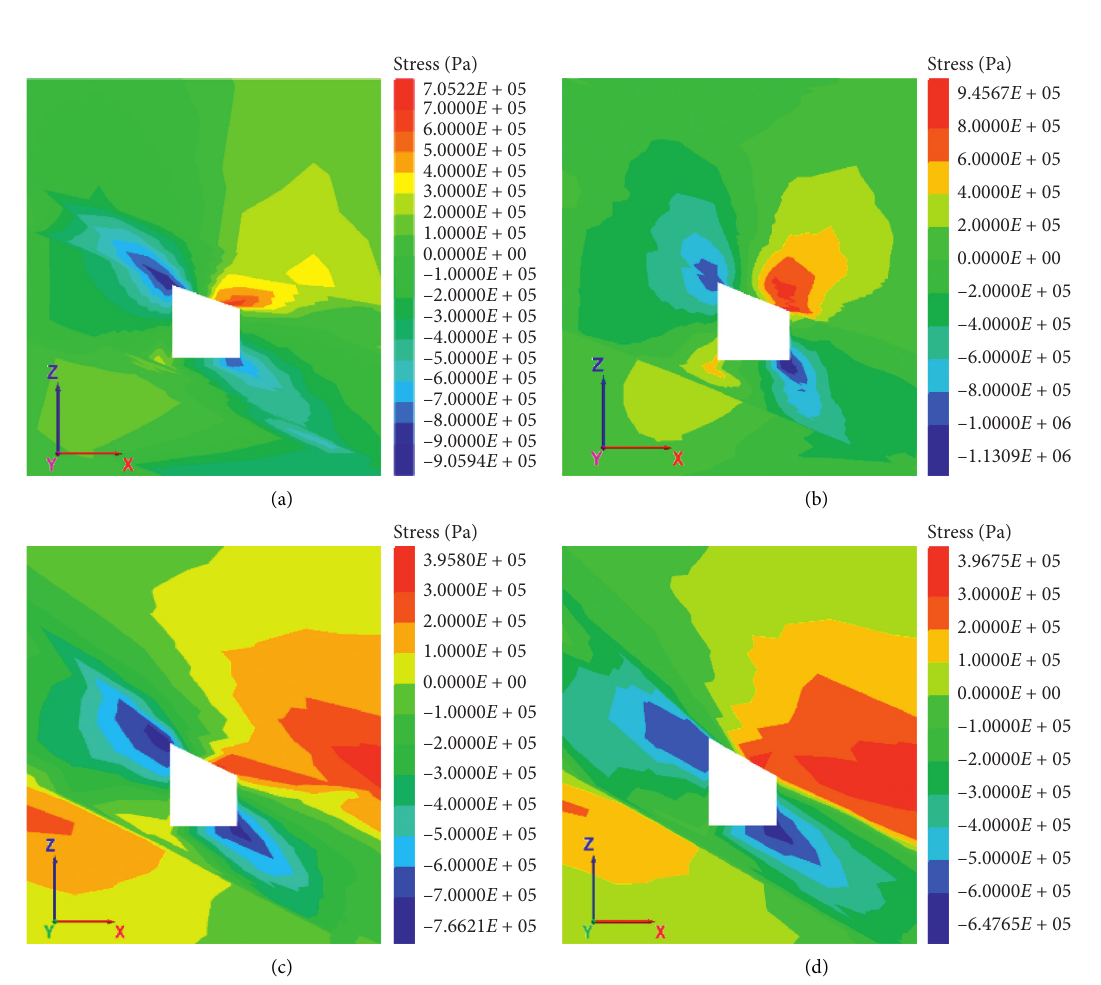
Figure 8: Horizontal stress distribution characteristics of the roadway. (a) 18 ° . (b) 21 ° . (c) 24 ° . (d) 27 °